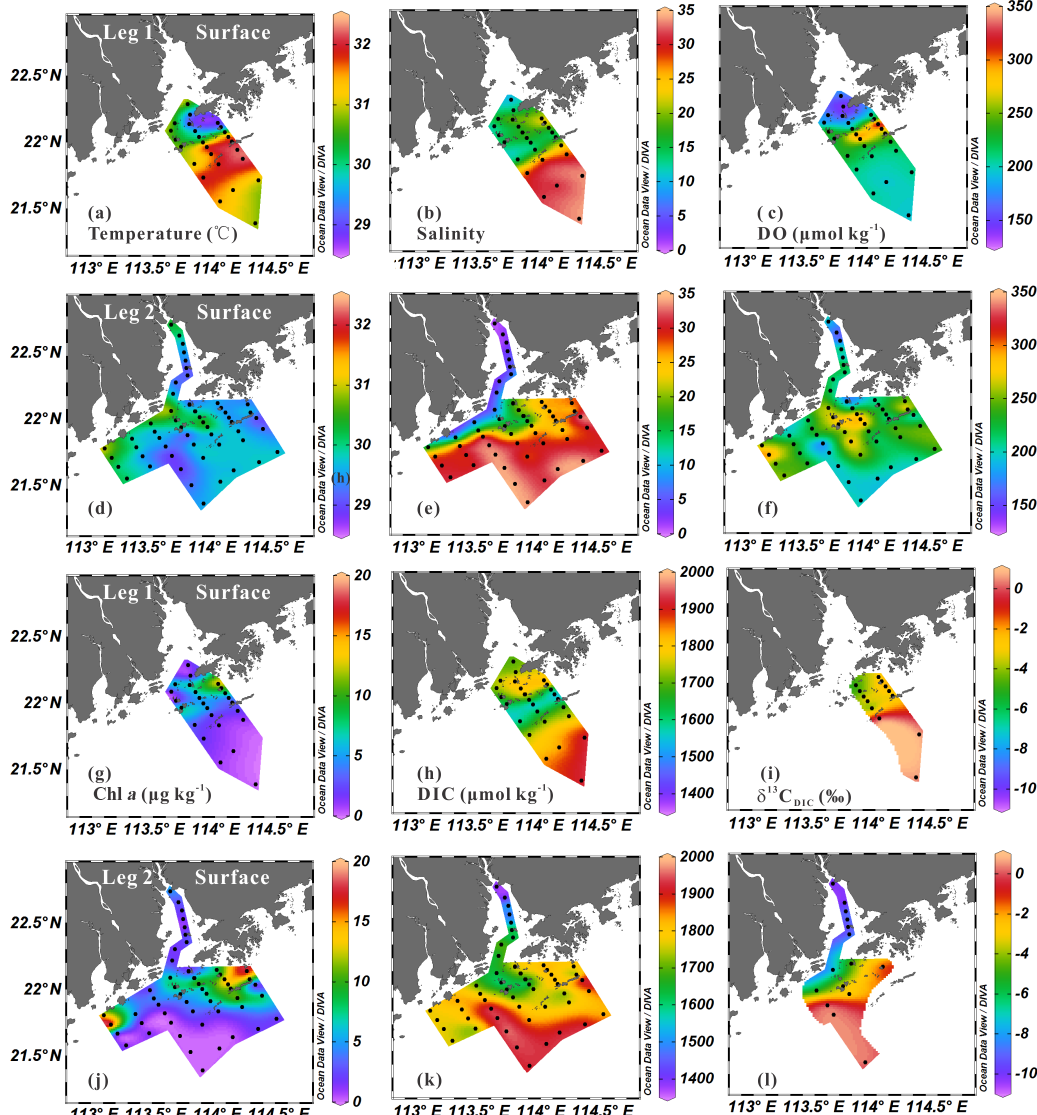
Figure 2. Surface water distribution of temperature, salinity, DO, Chl a , DIC and δ 13 C DIC during Leg 1 (a–c, g–i) and Leg 2 (d–f, j–l)